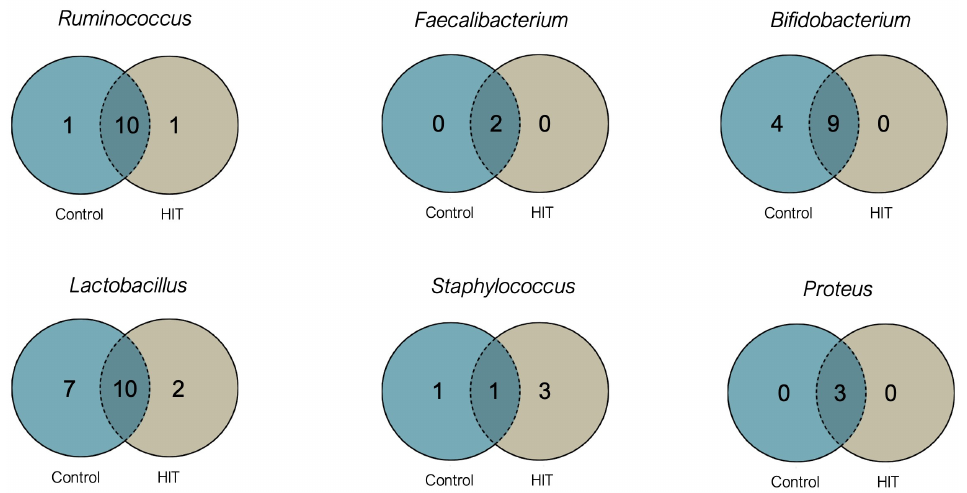
F igure 5 Figure 5. Venn diagrams of specific and shared Operational Taxonomic Units (OTUs) detected for